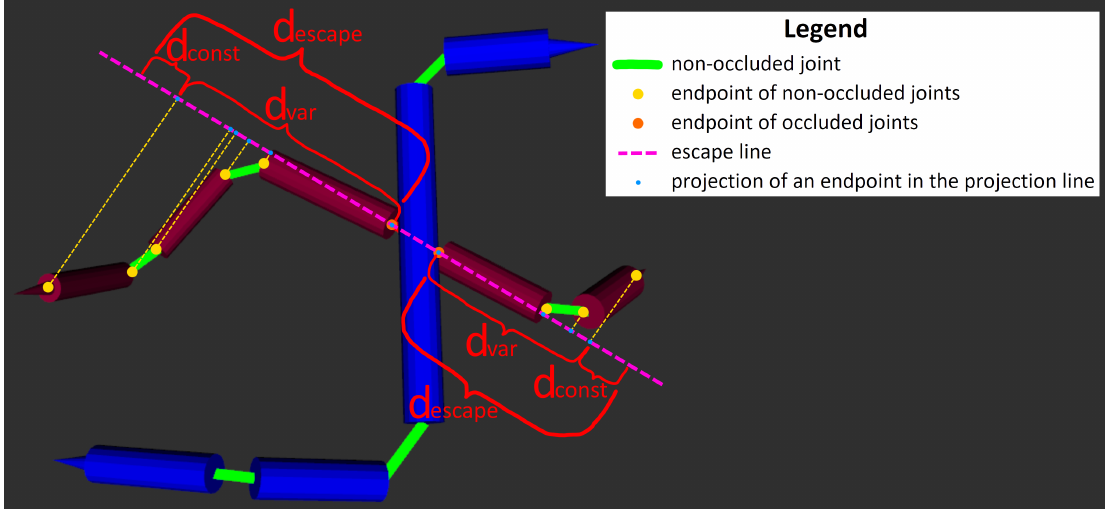
Figure 3. Visual representation of the escape line and distances for an occluded